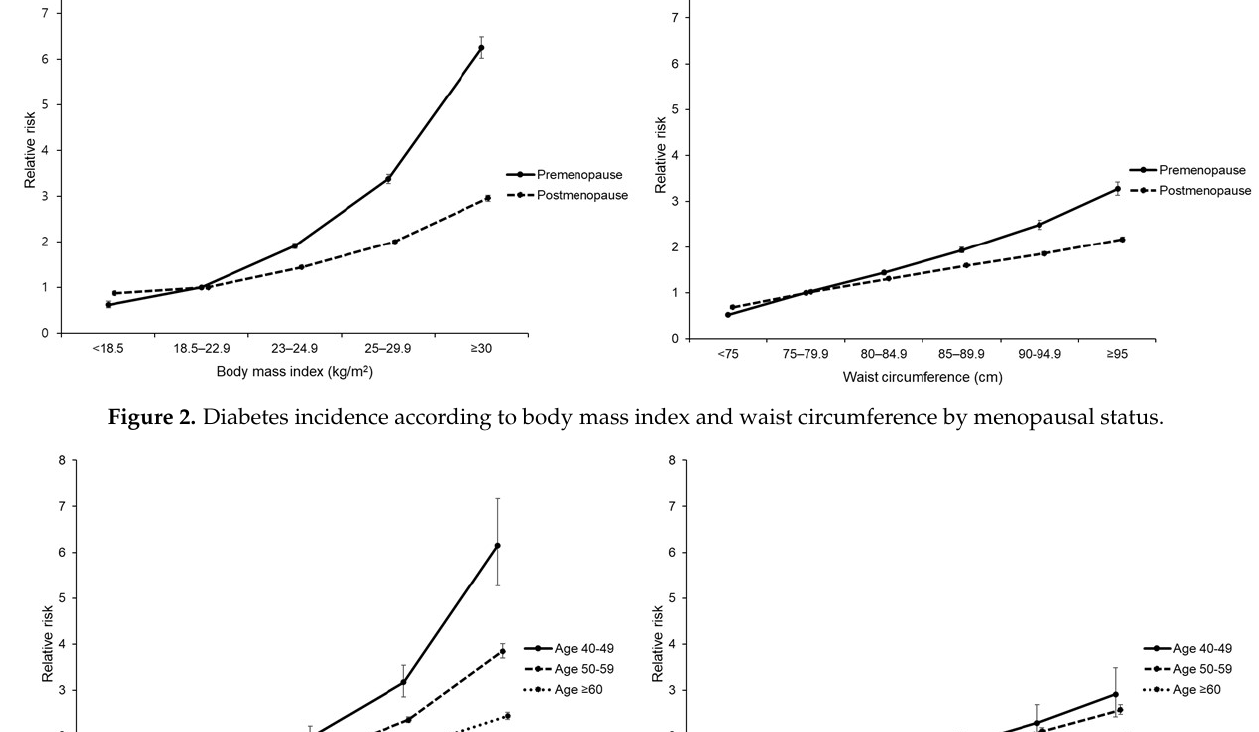
Figure 3. Diabetes incidence according to (A) body mass index and (B) waist circumference by age group.